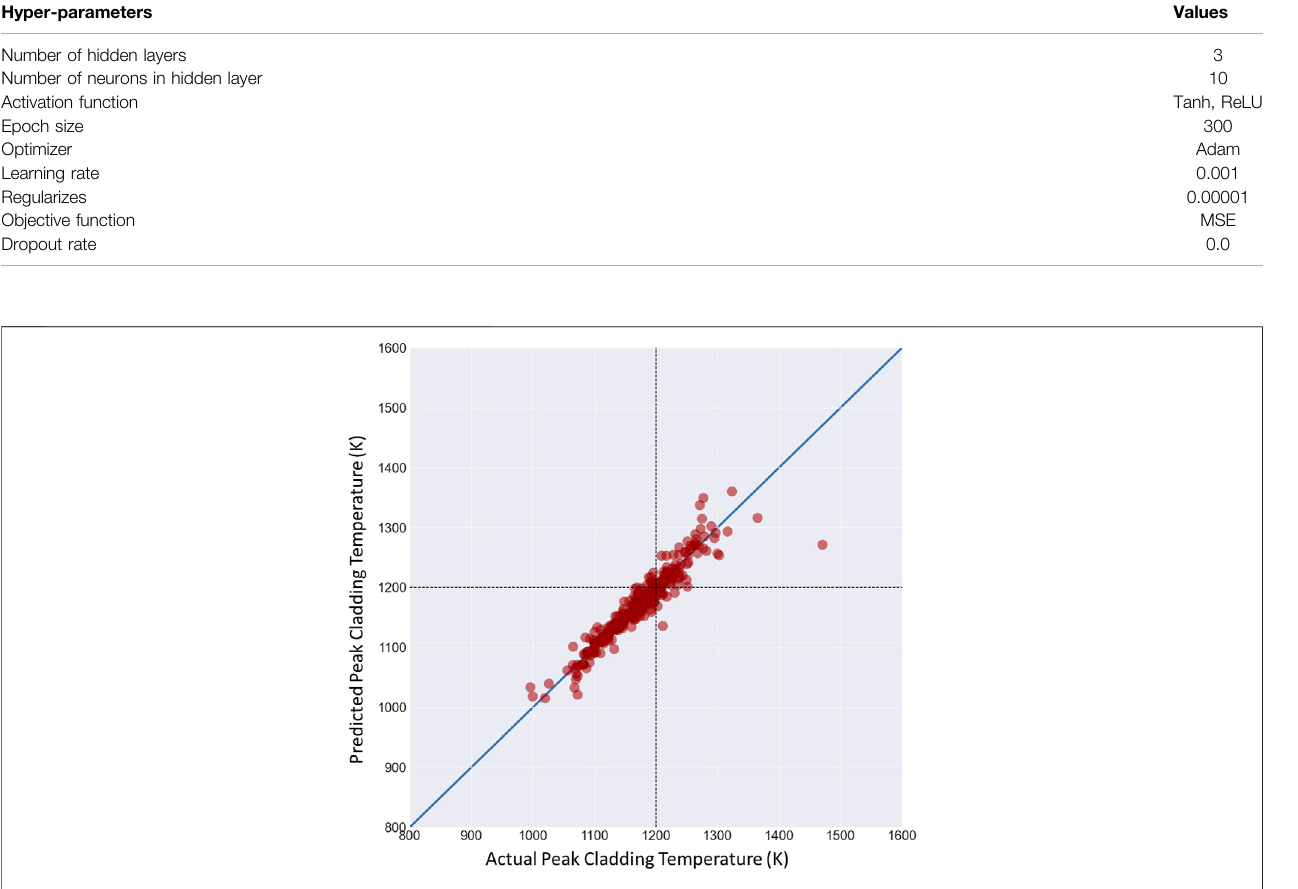
FIGURE 5 | Scatter plot for PCT using 19 uncertain parameters.